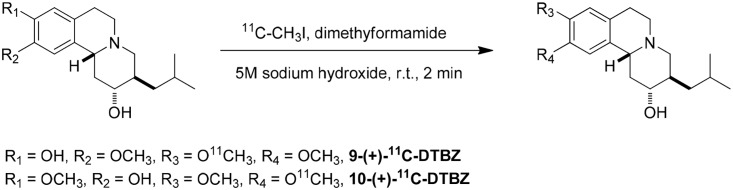
Radiochemical synthesis of 9-(+)-11C-DTBZ and 10-(+)-11C-DTBZ.